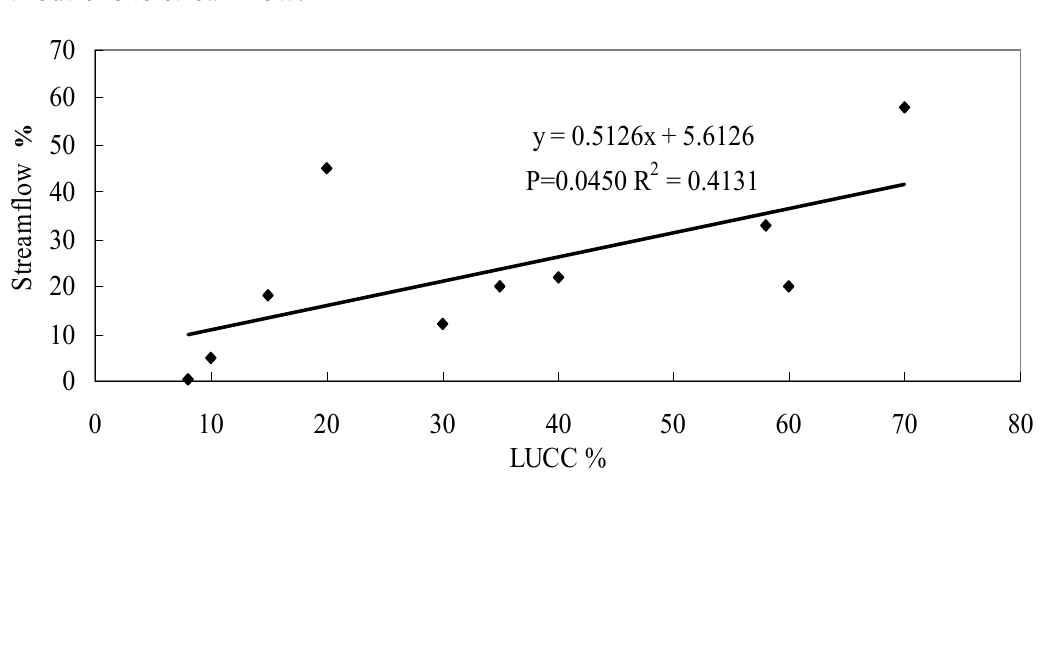
) and cumulative annual effective precipitation a